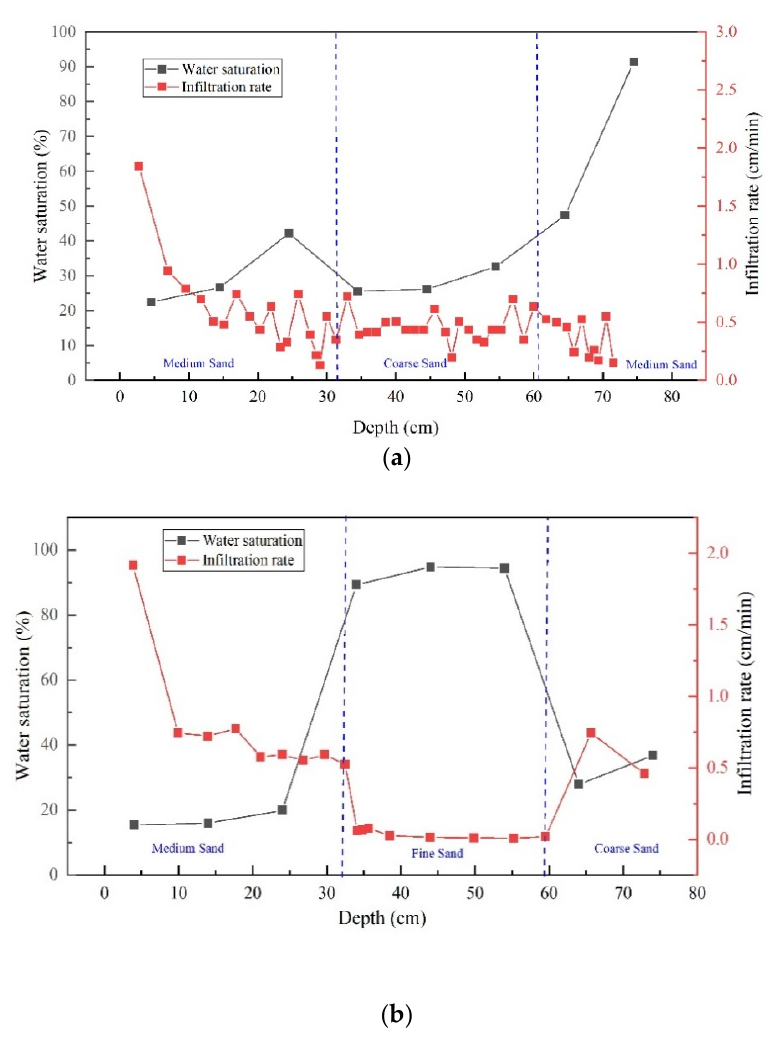
Figure 6. Comparison between water saturation and infiltration rate of the diesel front: ( a ) M-C-M; ( b ) M-F-C. High water saturation mean that soil pores were occupied by water, resulting in a decrease in the relative permeability of the LNAPL. Relative permeability depended on fluid saturation. The LNAPL front migration rate in the fine sand layer was very slow and almost stagnant because of the high water saturation of the fine media.